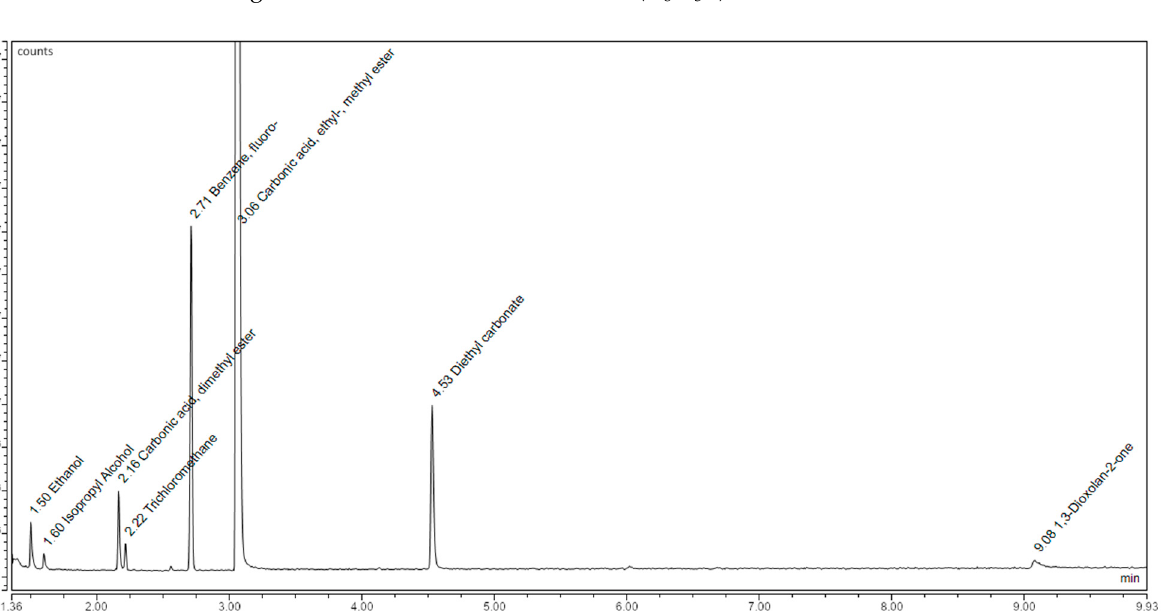
Table 5. Electrolyte and electrode dissolution in aqueous solution.